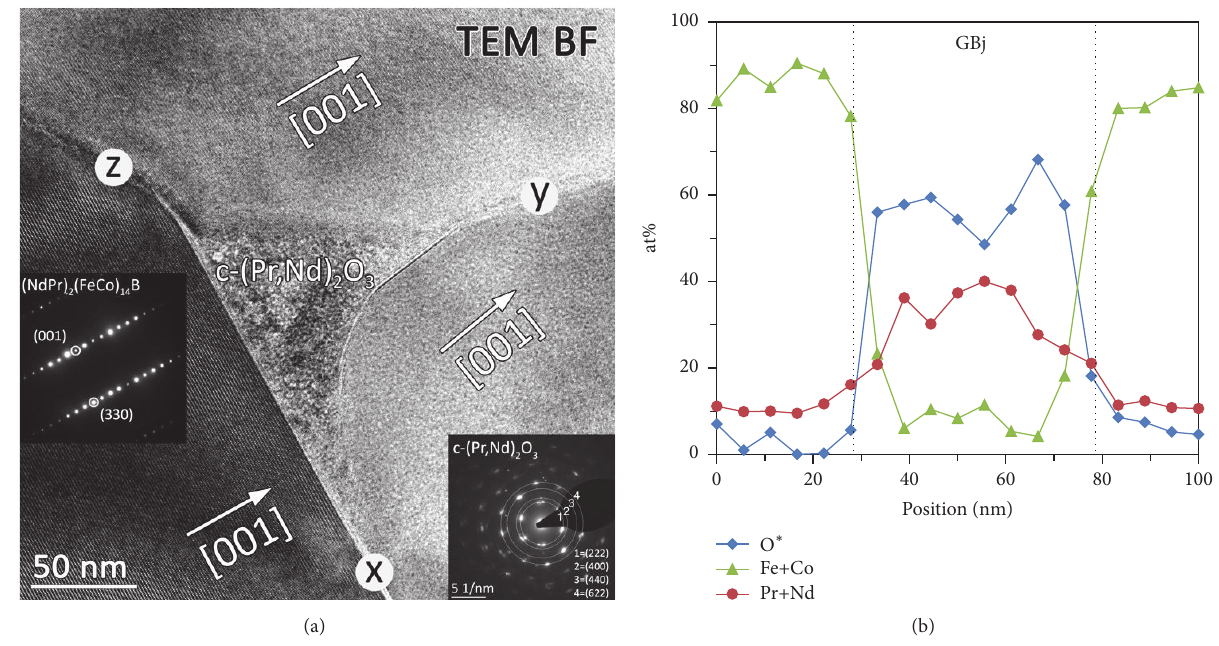
Figure 5: (a) TEM BF showing the c-(Pr,Nd) 2 O 3 GBj-1, also visible in Figure 4, and SAED images identify the phases; (b) EELS line scan over the GBj, low Fe content ( ≈ 5 at%), high RE, and O (ratio ≈ 2/3); O ∗ : the oxygen content was corrected (from the measured value) due to surface oxidation of the TEM specimen.